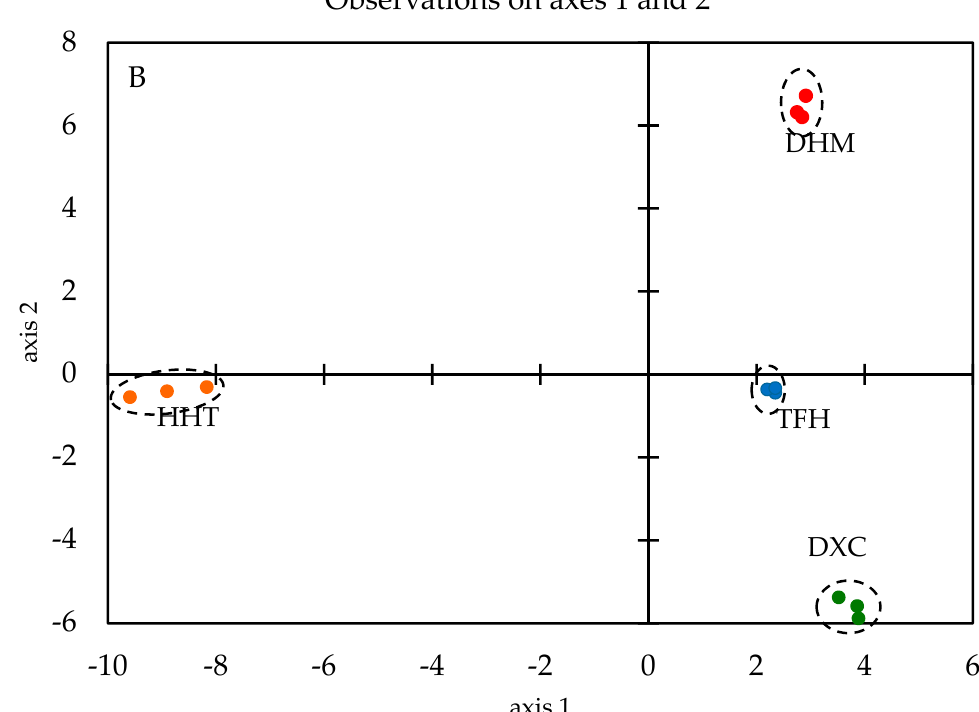
Figure 1. ( A ) PCA for odour-active compounds of the four marinated pork hocks. The blue dots represent the samples from marinated pork hocks, and the red dots represent odour-active compounds. ( B ) PLS-DA score plot from different marinated samples (R 2 X = 0.978, R 2 Y = 0.997, Q 2 = 0.994). The red dots represent DHM, the yellow dots represent HHT, the blue dots represent TFH, and the green dots represent DXC.